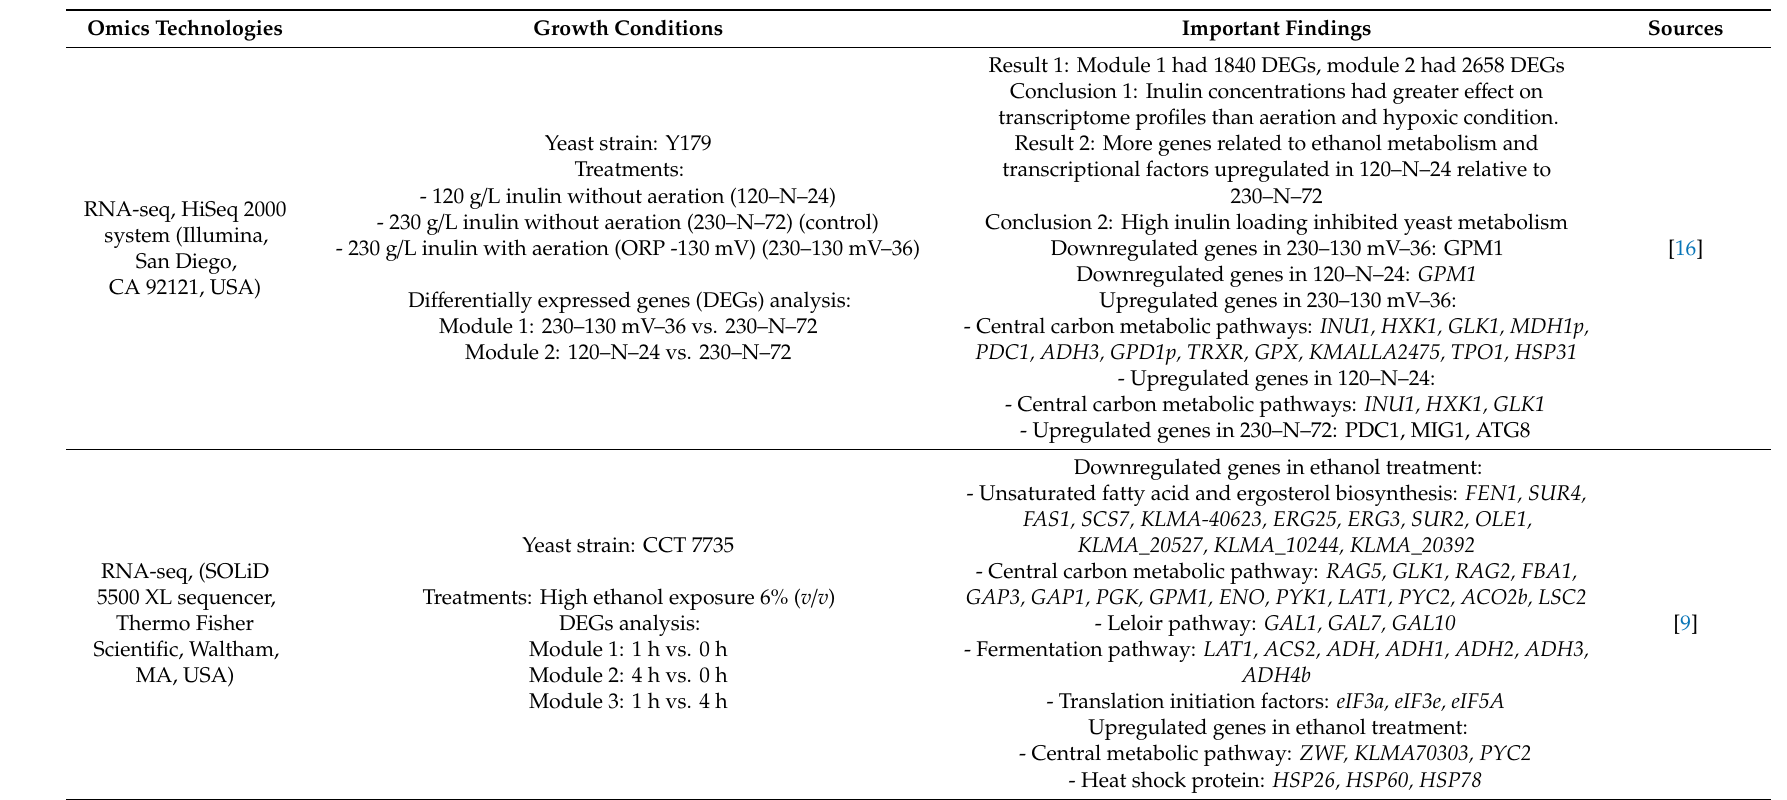
Table 1. A brief overview of Omics studies in K.